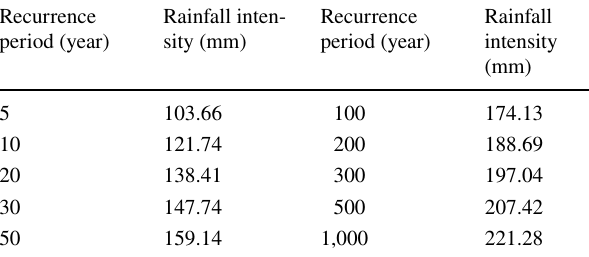
Table 3 Heavy rainfall intensities for different recurrence periods